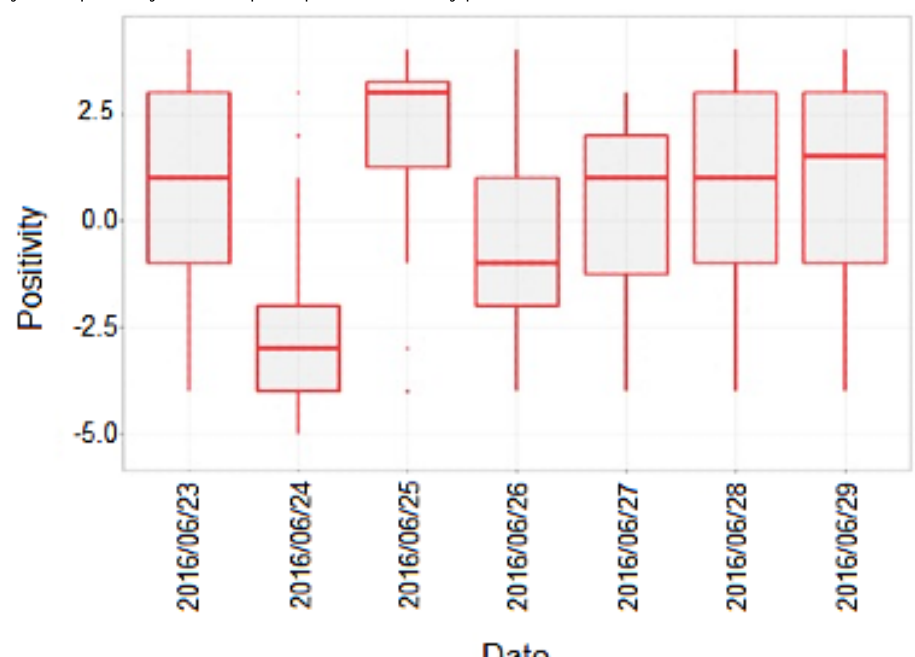
Figure 2. Daily mood positivity across all participants over a 7-day